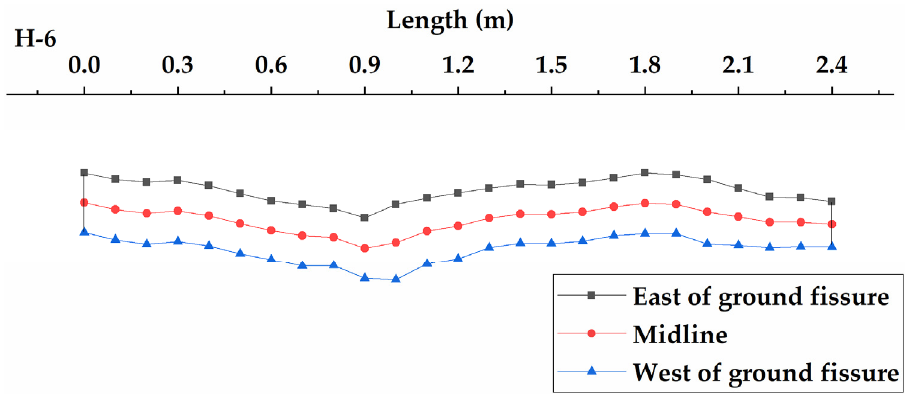
Figure 11. The ground fissure morphology of H-6.